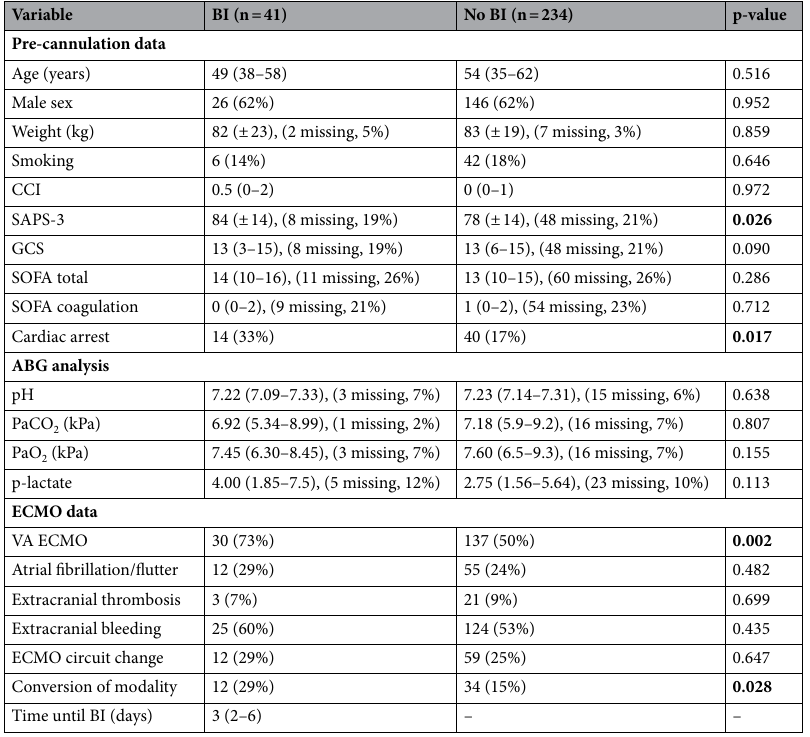
Table 1. Univariate regression analysis predicting brain infarction during extracorporeal membrane oxygenation. Normally distributed continuous data are presented as mean (± 1 SD), non-parametric continuous data as median (interquartile range) and categorical data as count (proportion). Bold text in the p value column indicates a statistically significant correlation (p < 0.05). ABG arterial blood gas, BI brain infarction, CCI Charlson comorbidity index, ECMO extracorporeal membrane oxygenation, GCS Glasgow Coma Scale, SAPS-3 Simplified Acute Physiology Score III, SOFA Sequential Organ Failure Assessment, VA